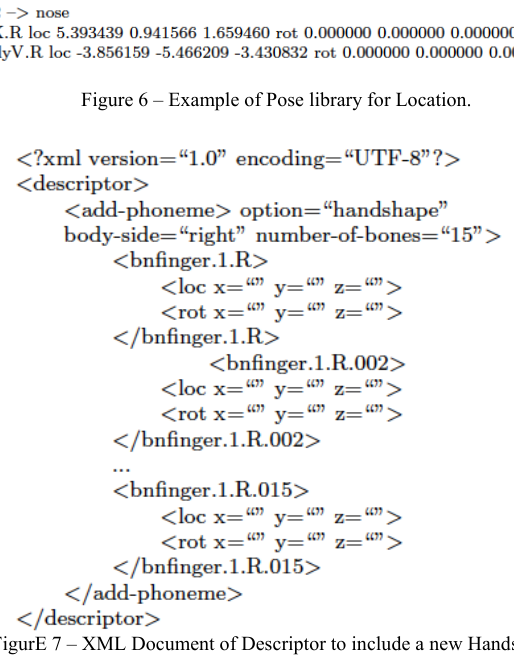
Figure 5 - Excerpt from XML document to represent phonological constraints.